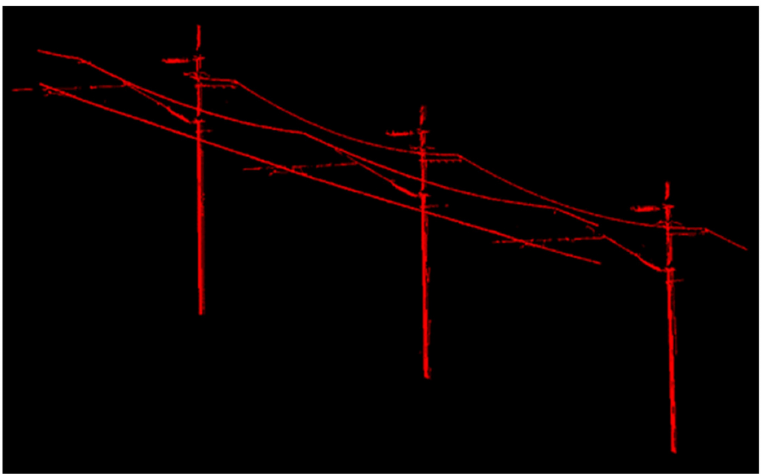
Figure 7. Railway OCS point cloud with a length of 100